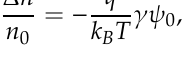
=10 AT ψ − . ( a ) Effective 0